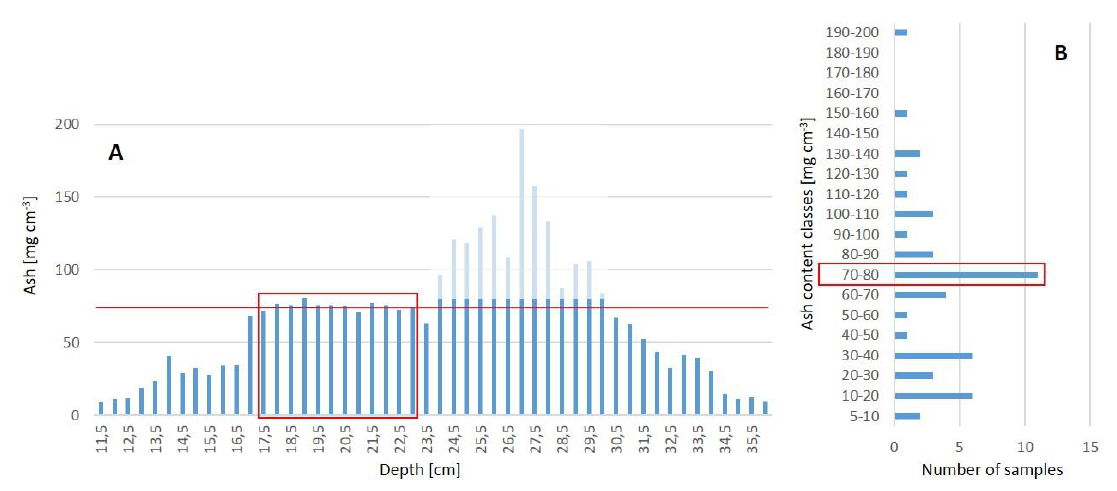
Figure 4. ( A ) Ash content in relation to depth in layer B of PW illustrating correction of the highly erratic high ash contents in samples 24–30 cm. Red horizontal line: ash level above which external input is assumed; red box: the average ash content of these samples was used to replace the values between 24 and 30 cm in the ‘corrected’ calculations. ( B ) Number of values per ash content class: red box—class with most values, including all values used to calculate the replacement correction value.